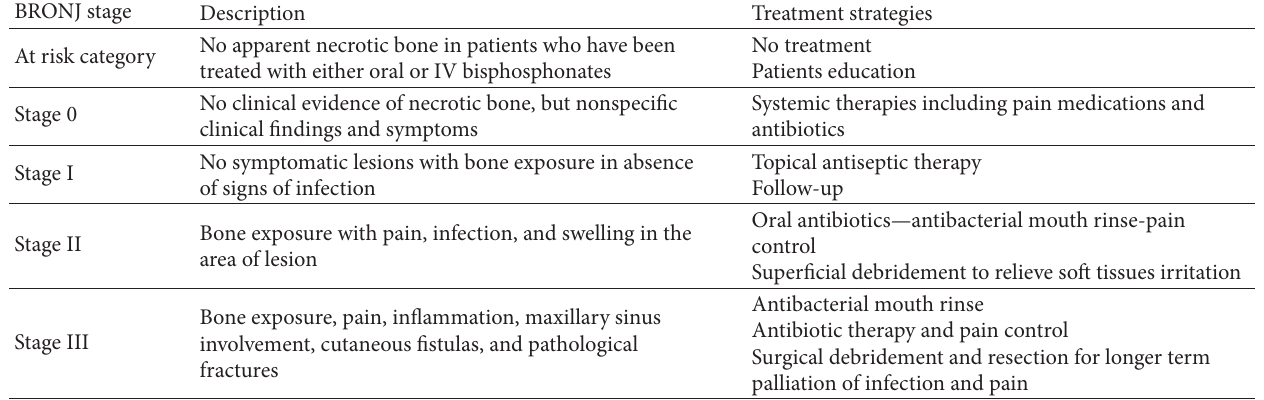
Table 1: Clinical classification of BRONJ by Ruggiero et al. [3]